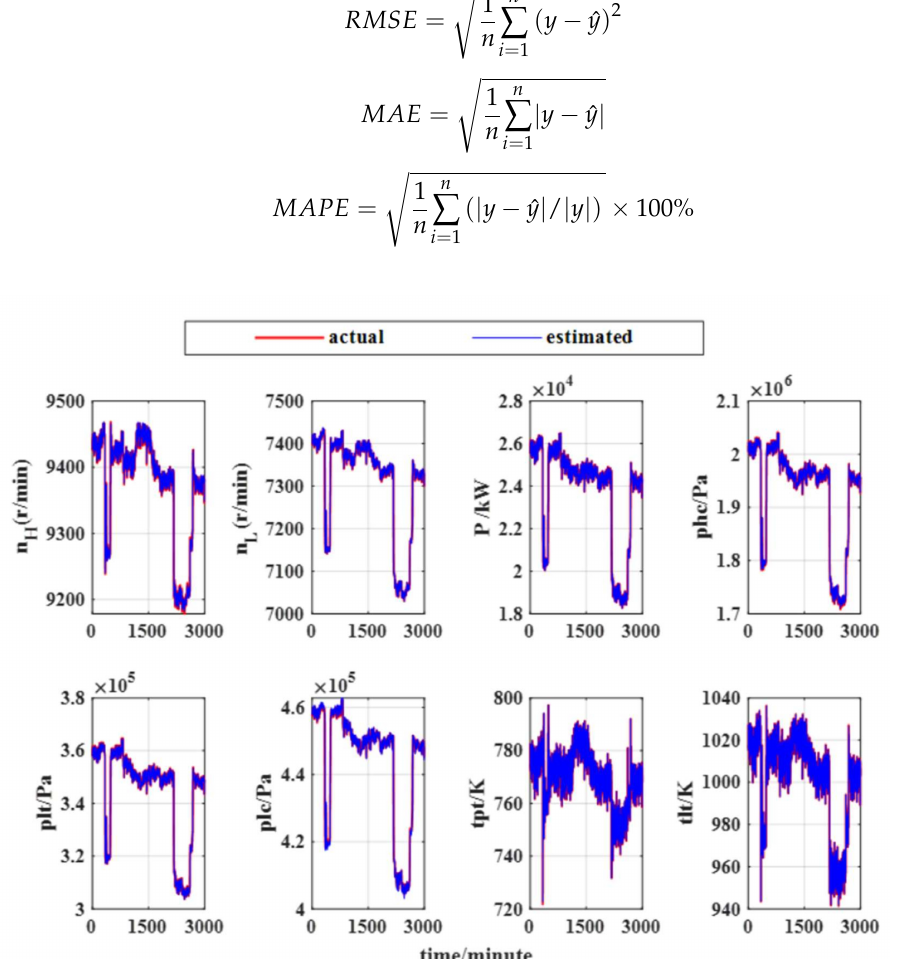
Figure 14. Actual data versus estimated data in test